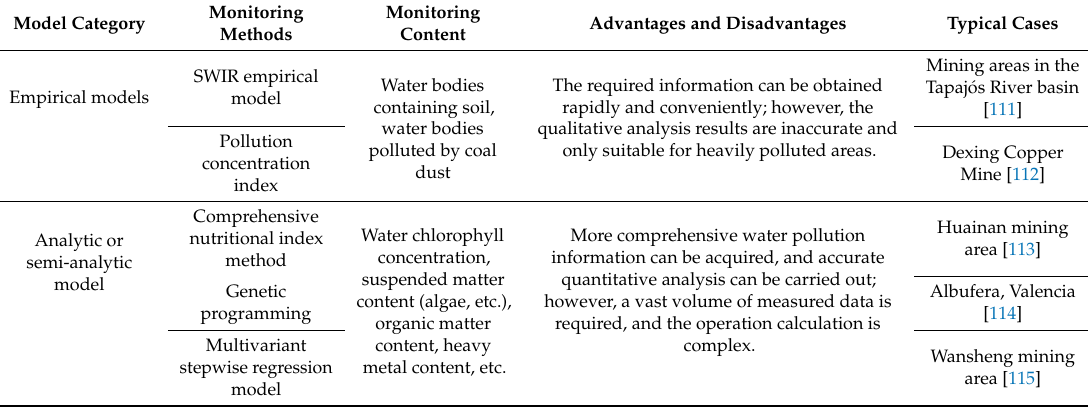
Table 2. Remote sensing monitoring of water pollution information in mining